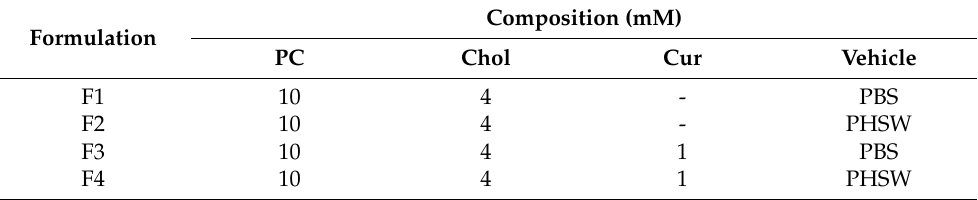
Table 2. Liposome